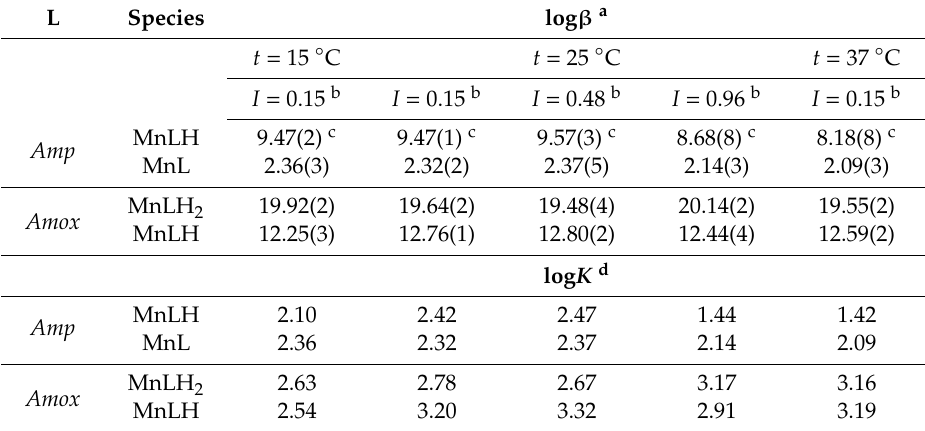
Table 1. Experimental formation constant values for Mn 2 + - Amp (L), Mn 2 + - Amox (L) species obtained by potentiometry at di ff erent temperatures and ionic